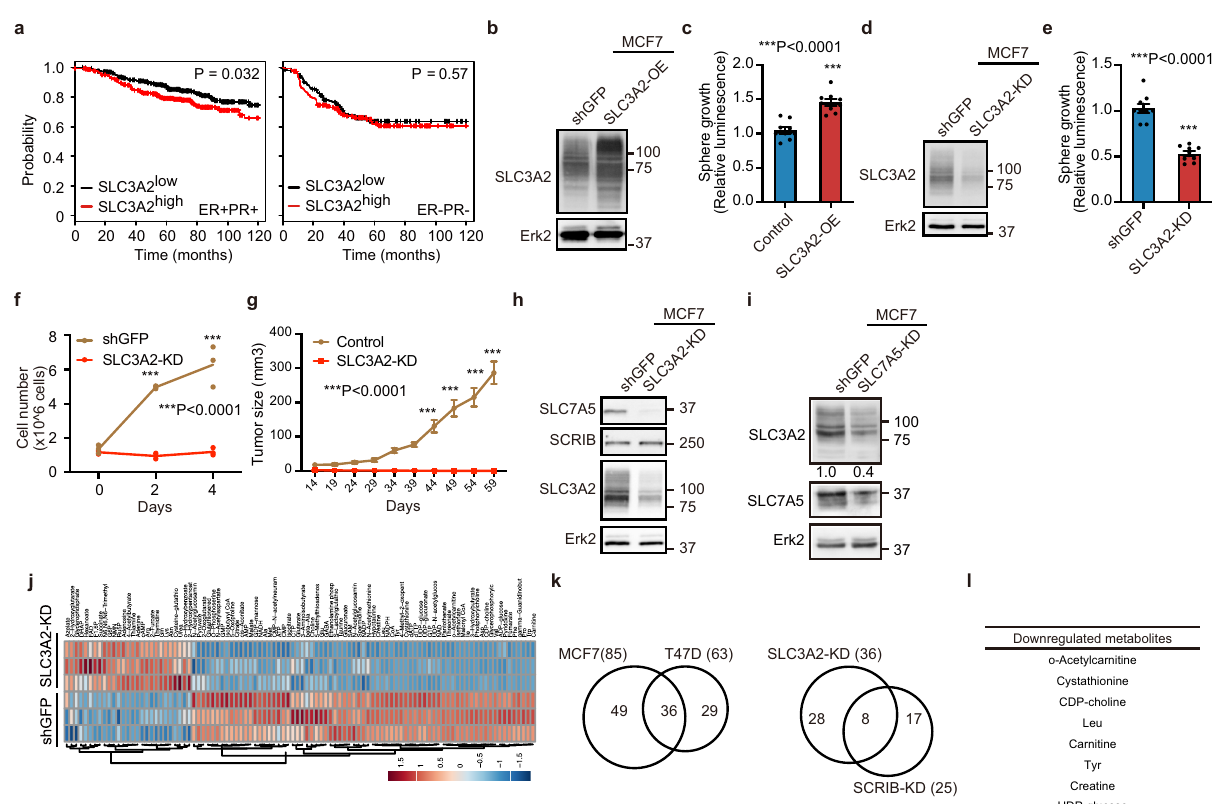
Fig. 5 SLC3A2 promotes cell proliferation in ER + breast cancer cells. a Kaplan – Meier plots of ER + /PR + and ER − /PR − BC patients ’ survival. b Overexpression of SLC3A2 in MCF-7 cells. c Cell viability assay of SLC3A2-OE MCF-7 cells. d Knockdown of SLC3A2 in MCF-7 cells. e Cell viability assay of SLC3A2-KD MCF-7 cells. f 2D growth of SLC3A2-KD MCF-7 cells. g Tumor growth of SLC3A2-KD MCF-7 cells in NSG mice. h Total protein levels of SLC7A5 in SLC3A2-KD MCF-7 cells. i Total protein levels of SLC3A2 in SLC7A5-KD MCF-7 cells. j Heatmap of metabolites in SLC3A2-KD MCF-7 cells. k Venn diagram representation of the number of intracellular metabolites downregulated by SLC3A2-KD in MCF-7 and T47D cells (left) and downregulated in both SLC3A2-KD and SCRIB-KD cells (right). l List of metabolites downregulated by SLC3A2-KD and SCRIB-KD. Data c , e , f , and g are shown as mean ± s.e.m.; c , and e ; n = 9 from three biological replicates performed in triplicate, f ; n = 3, g ; n = 5 for control cells and n = 4 for SLC3A2-KD cells. Statistical analysis was conducted by t -test ( c , e ), and two-way ANOVA followed by Tukey ’ s posttest ( f ) or Sidak ’ s posttest ( g ).